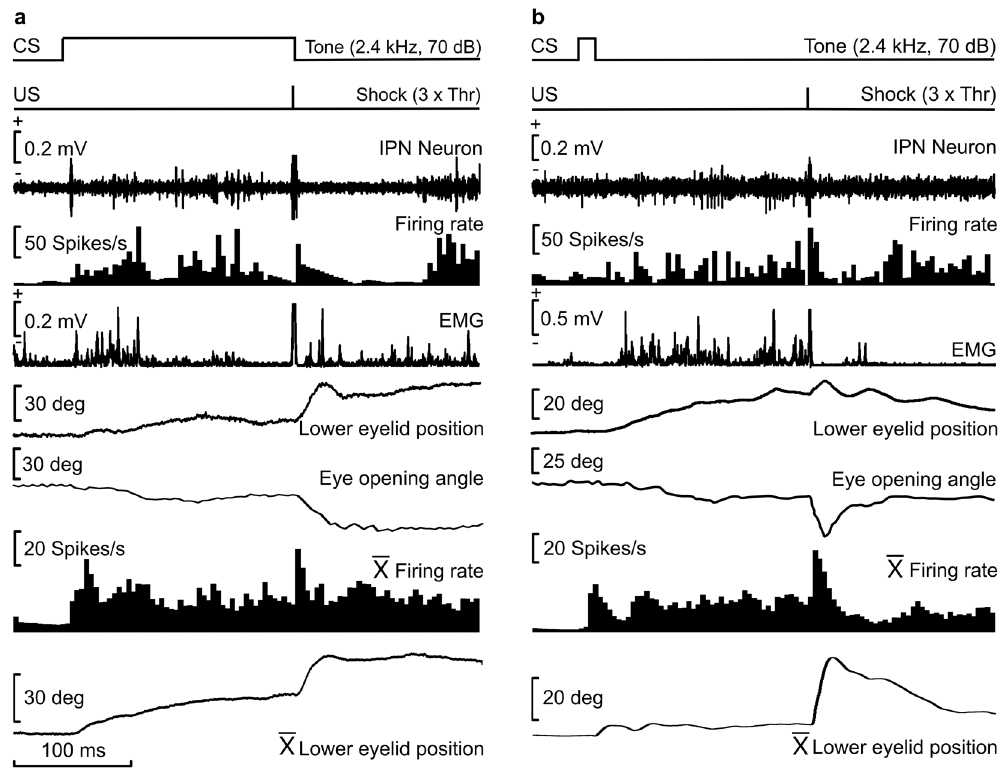
Figure 3. Firing activities of type A neurons during two different conditioning sessions using delay ( a ) or trace ( b ) conditioning paradigms. From top to bottom are represented the conditioning paradigm (CS and US presentations), the firing activity of the IPN neuron, the firing rate, the rectified EMG activity of the OO muscle, the lower-eyelid position detected on-line with the Hall-effect sensor, and the eye-opening angle detected off-line through a MATLAB-based analysis of photographs taken with a fast CCD camera. At the bottom are represented the averaged firing rate and the lower-eyelid position collected during the trials 41 to 60 of a single conditioning